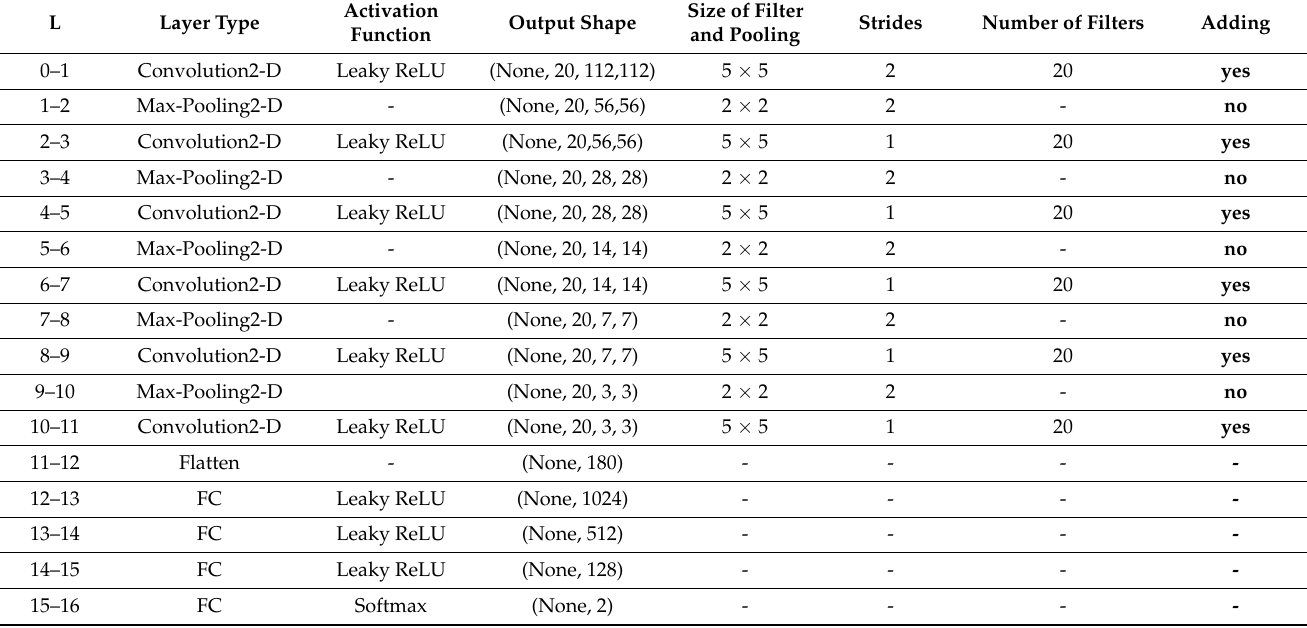
Table 1. The number of filters, stride size, and architectural details of the customized CNN